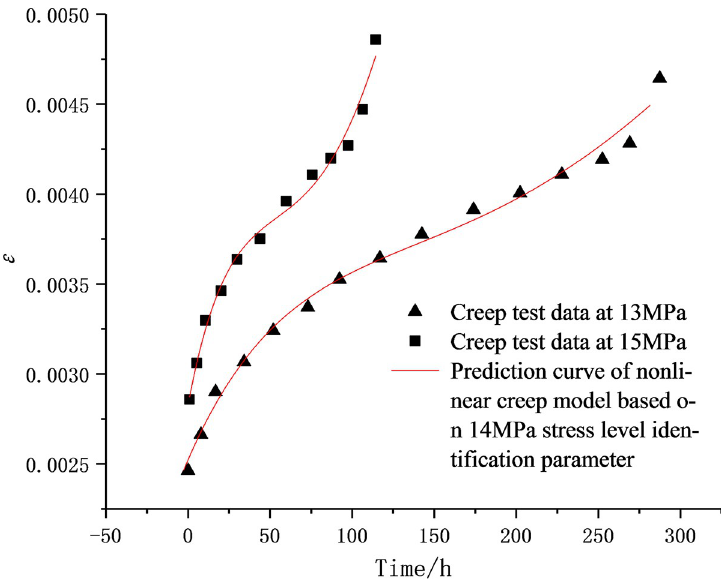
Fig 14. Comparison between the predicted curve and the test curve under stress levels of 14 MPa and 13 MPa.